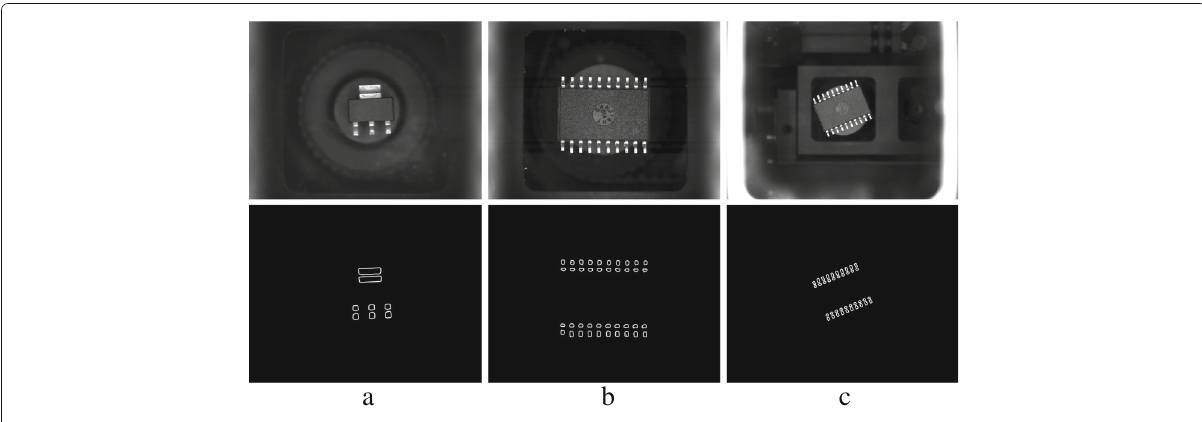
Fig. 11 Real devices (first row) and their respective thresholded versions (second row). a SOP1. b SOP2. c SOP3